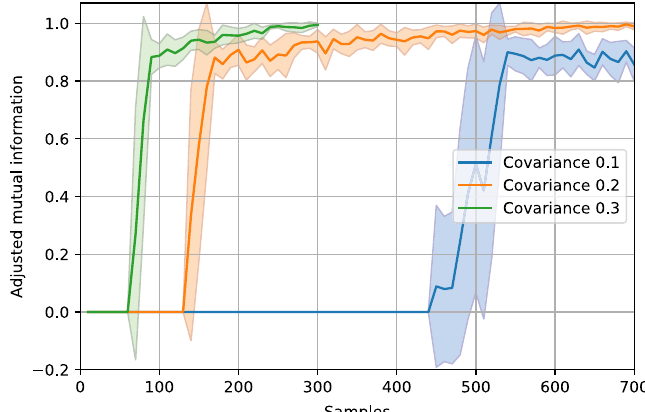
Fig. 5 AMI with varying number of samples. The adjusted mutual information (AMI) between planted and recovered partitions increases rapidly and is large ( > 0.8 ) for a wide range of samples. Further increasing the number of samples only gives small gains in AMI